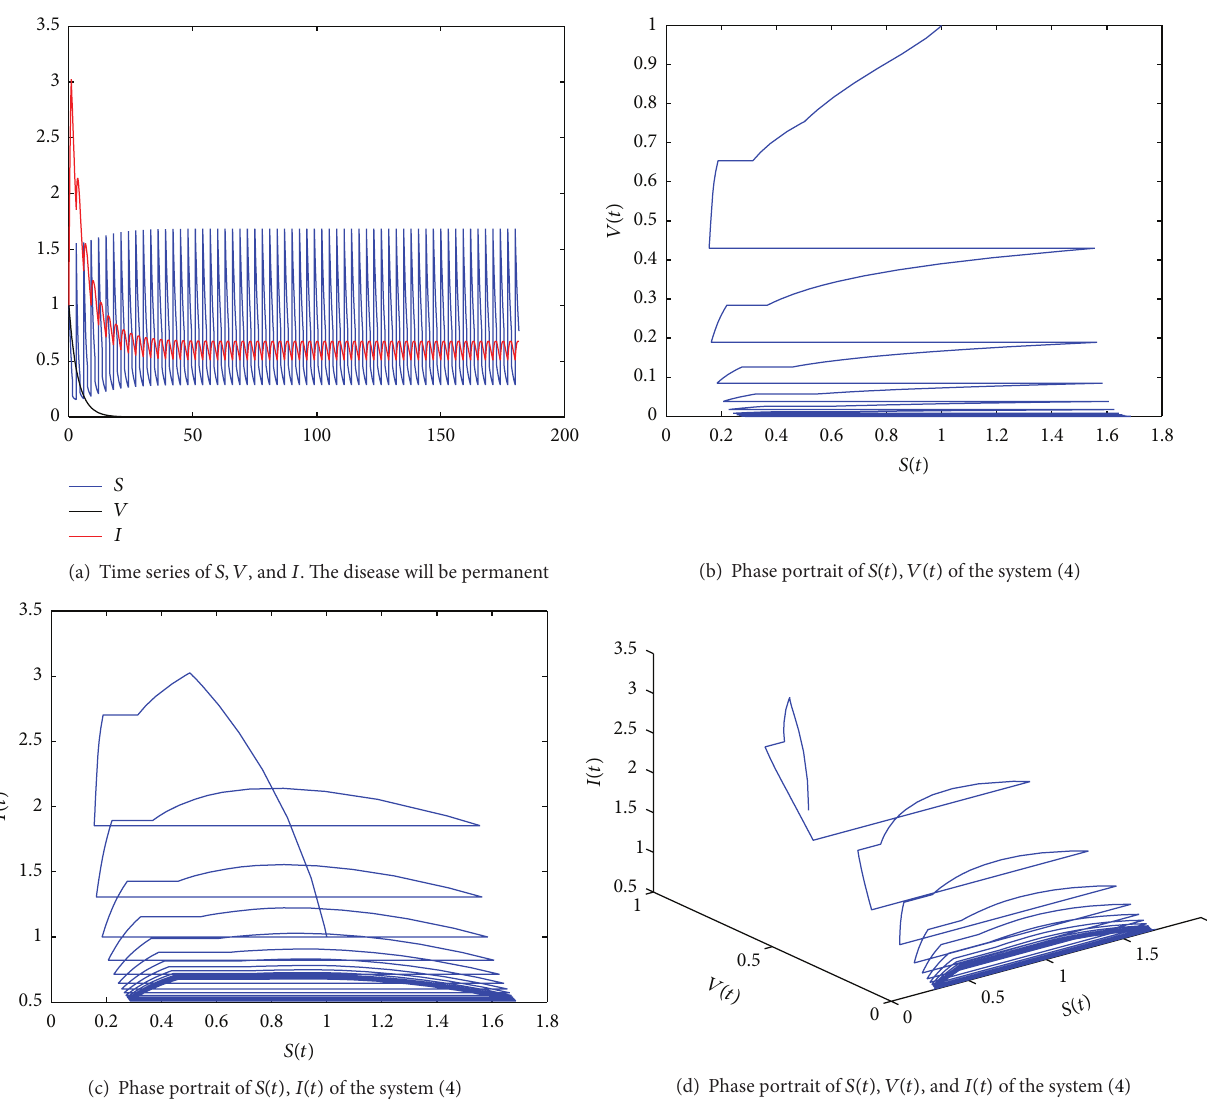
Figure 1: The results of numerical simulation on the threshold values R 2 = 2.6155 > 1 , where 𝑝 = 1.5 , 𝑞 = 1.25 .